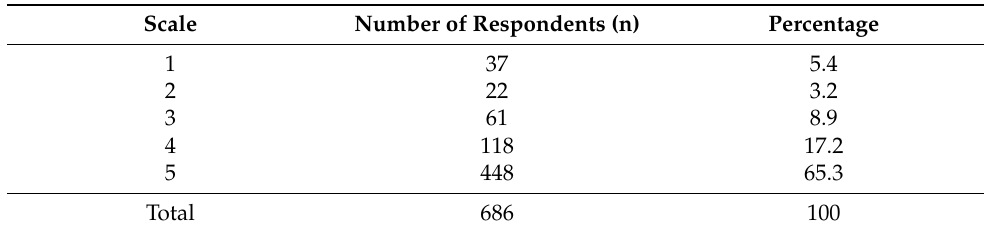
Table 2. Adult time at home compared to pre-lockdown determined using a Likert-like scale from 1 “No more than normal” through to 5 “Far more than